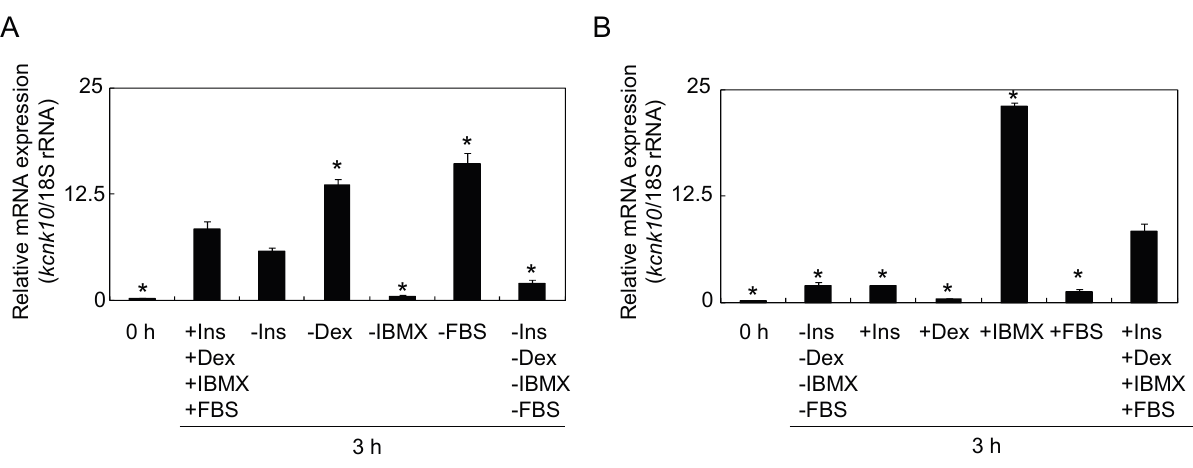
Figure 1. Effect of adipogenic inducers on the kcnk10 expression. ( A ) The effects of